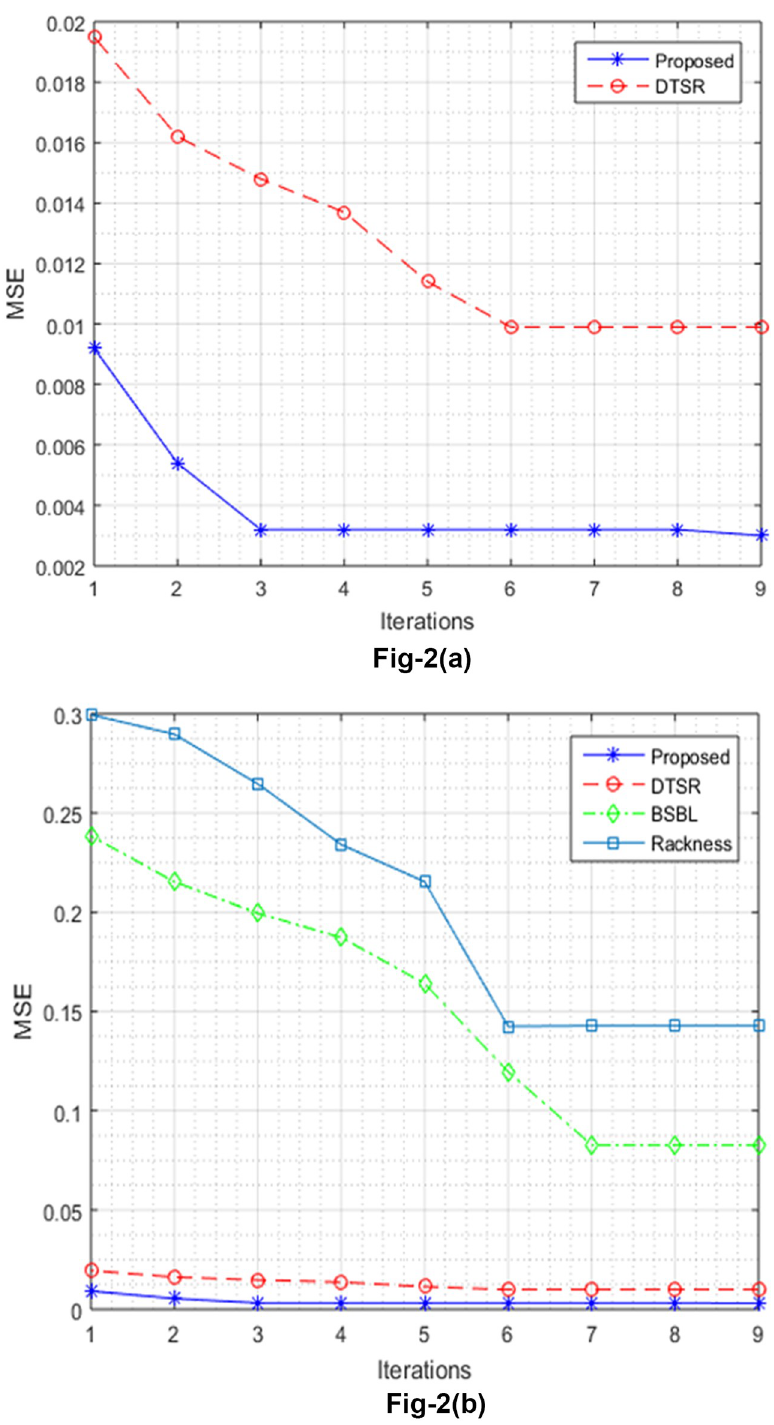
Fig 2. MSE vs iterations. A: Original vs proposed method. B: Comparison with related methods.